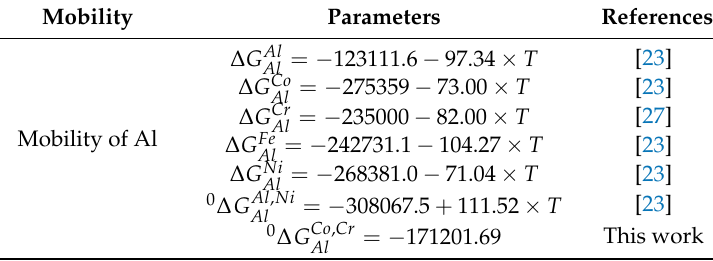
Table 2. List of the assessed mobility parameters during evaluation of the composition-dependent interdiffusion coefficients in fcc Al–Co–Cr–Fe–Ni HEAs at different